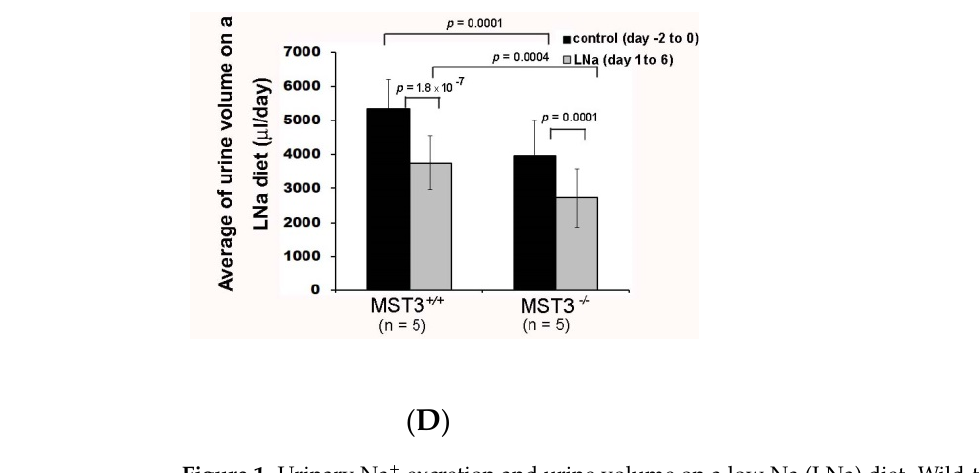
Figure 1. Urinary Na + excretion and urine volume on a low Na (LNa) diet. Wild-type (WT) (MST +/+ ) ( ● ) and MST3 − / − ( ○ ) mice were fed the control diet for 3 days; then, the diet was changed to the LNa diet for an additional 16 days. The average group values were used to generate the graphs, and the error bars correspond to SE. Urinary Na + excretion ( A ) and urine volume ( C ) were recorded over 9 days. The bar graphs ( B , D ) show the average of the data in ( A , C ), respectively. Table 1. The values of weight, water intake, and food intake in 8-week-old C57Bl/6 male mice fed control or high salt diets. Control Diet